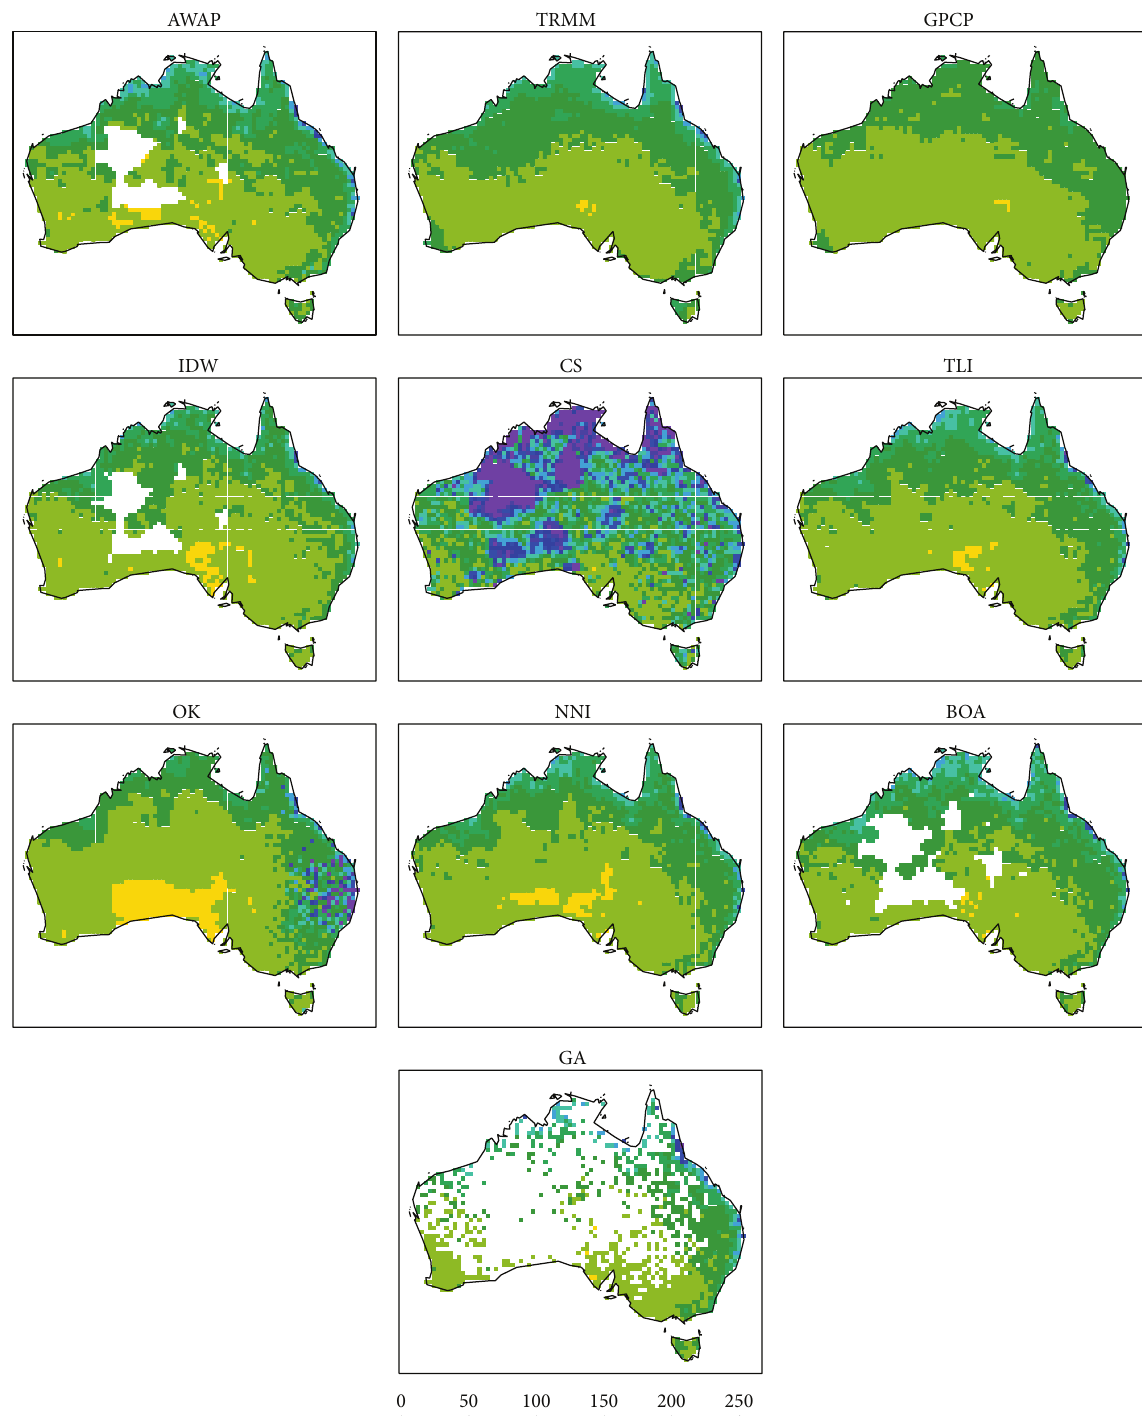
Figure 3: Maps of annual maximum daily precipitation at each grid point of Australia averaged over the period from 1998 to 2013, using three existing gridded datasets (AWAP, TRMM, and GPCP) and seven other gridded datasets calculated for the purposes of this study using daily precipitation data from the GHCN-Daily dataset. Refer to the text for more details. Units: